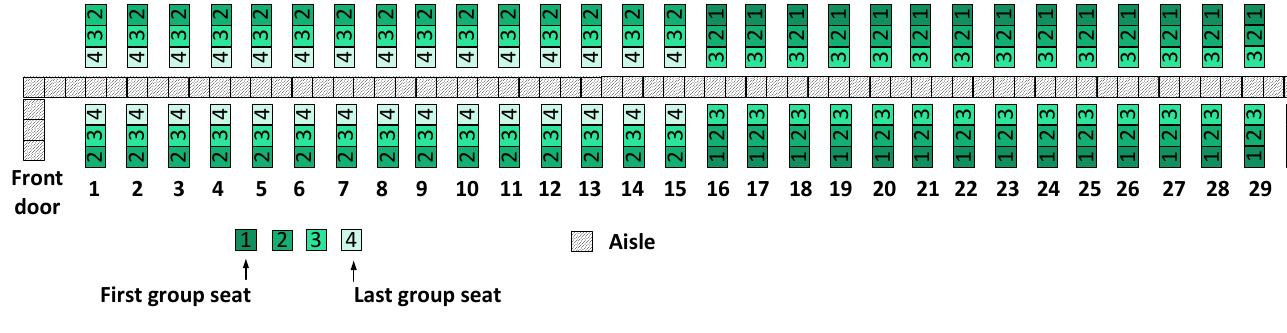
Figure 7. Reverse